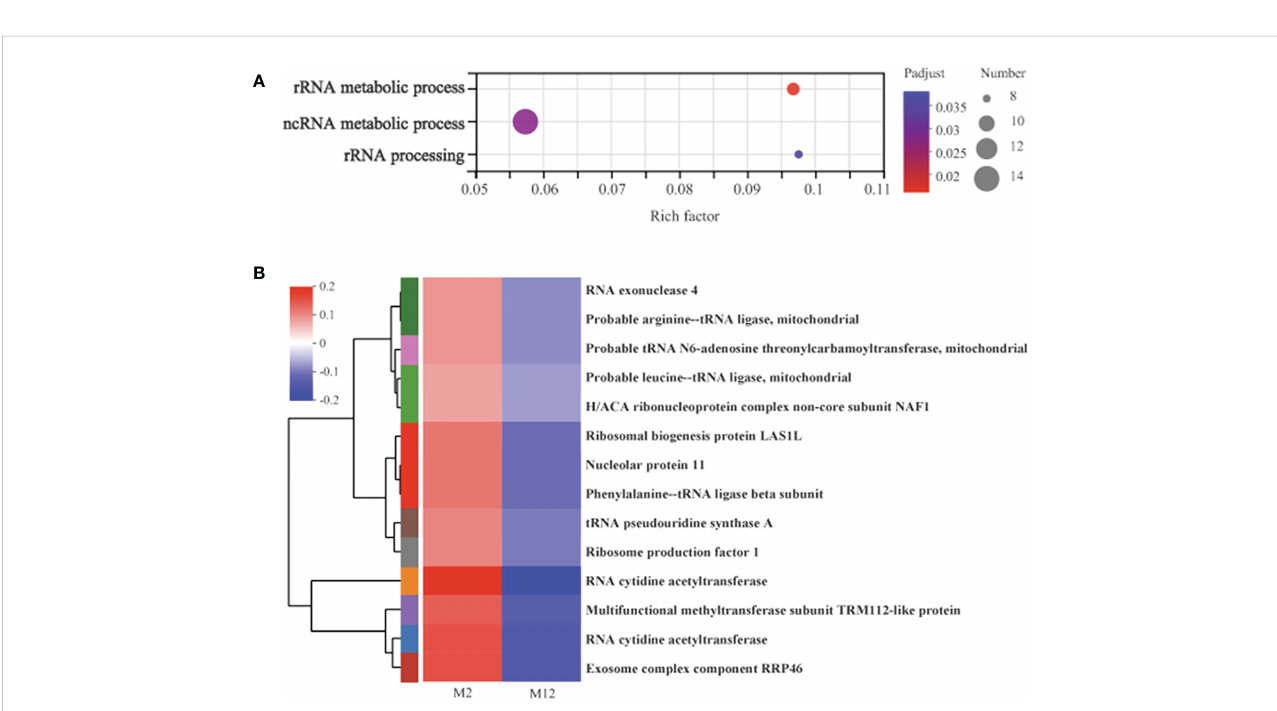
FIGURE 6 The functional enrichment and expression analysis of late-response genes to oyster induction. (A) GO enrichment results of 397 DEGs in M2 vs. M12 comparison. (P adjust < 0.05). (B) Heat map of the expression analysis of 14 DEGs in GO:0016072 (rRNA metabolic process) and GO:0034660 (ncRNA metabolic process), GO:0006364 (rRNA